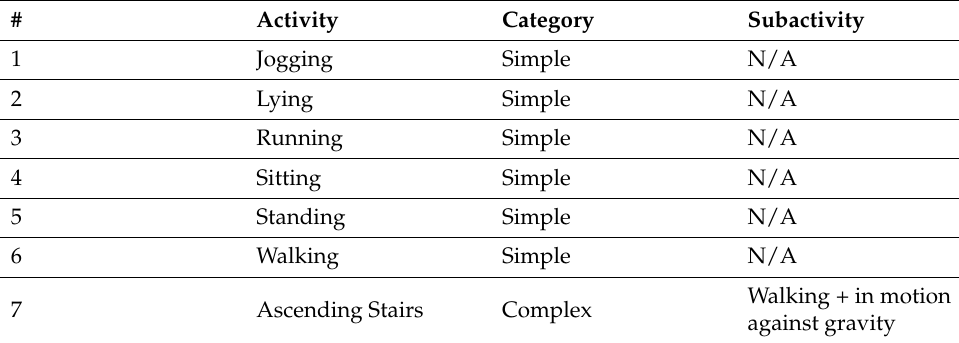
Table 1. Simple and complex activities within